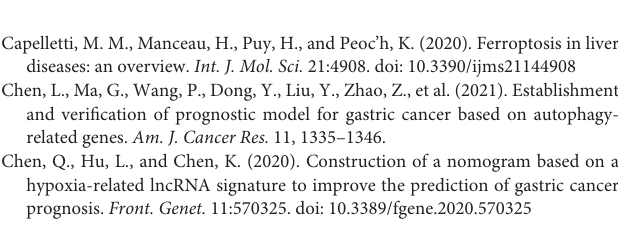
Supplementary Table 6 | PPI relationship details. Supplementary Table 7 | The KEGG enrichment analysis details. Supplementary Table 8 | GO annotation analysis